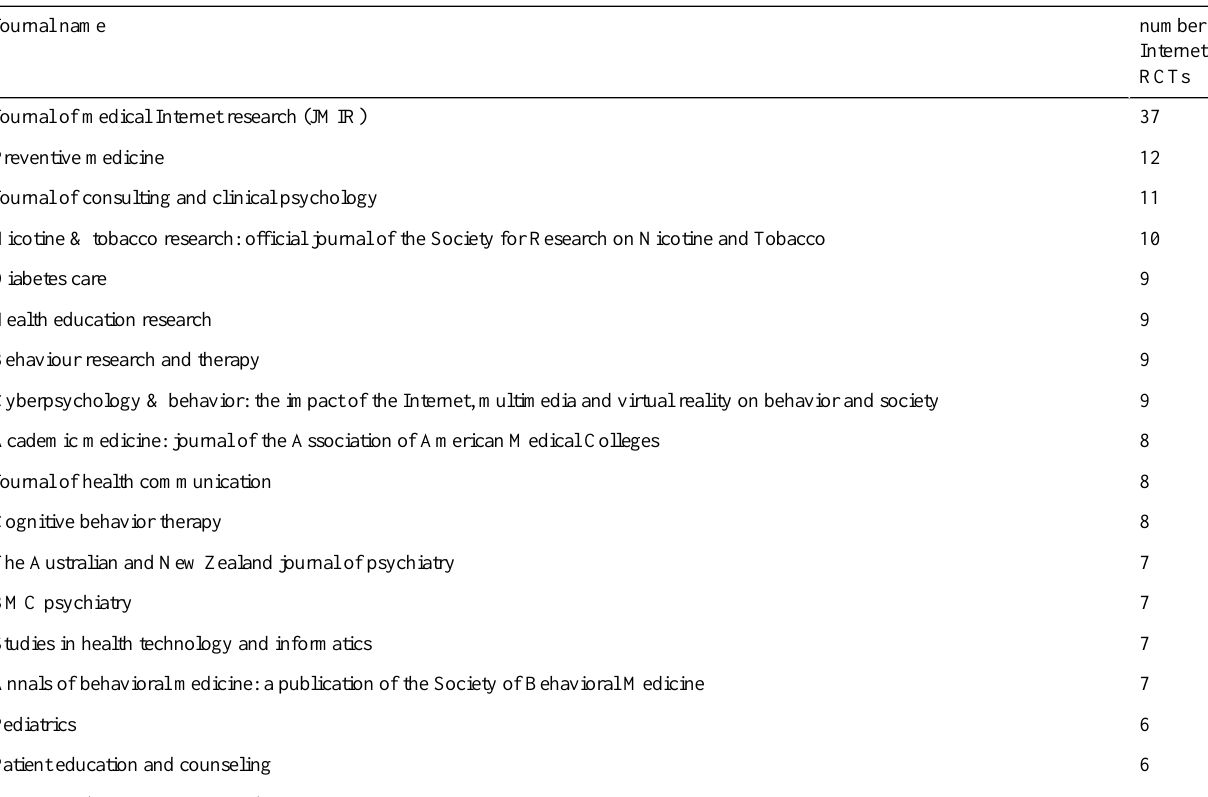
Table 1. Ranking of journals which have published at least 4 randomized trials of web-based applications (indexed with “Internet” as major MeSH heading and publication type = RCT) [from a list of a total of 582 trial publications], as of October 2010 (journal titles as per